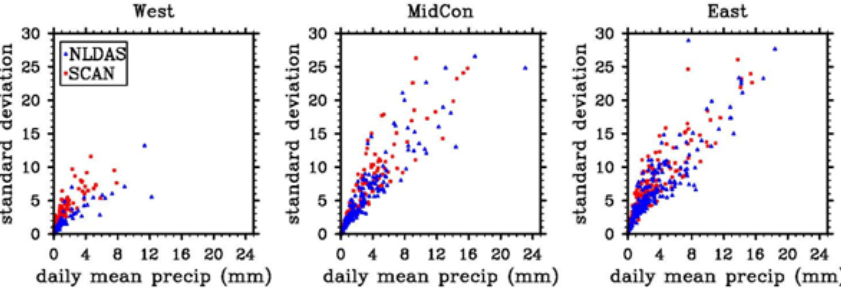
Fig. 8. Spatial variability (standard deviation) of daily precipitation (mm) as a function of mean precipitation. Daily precipitation of NLDAS and SCAN were first calculated at each SCAN location and then used to calculate spatial mean and standard deviation in each